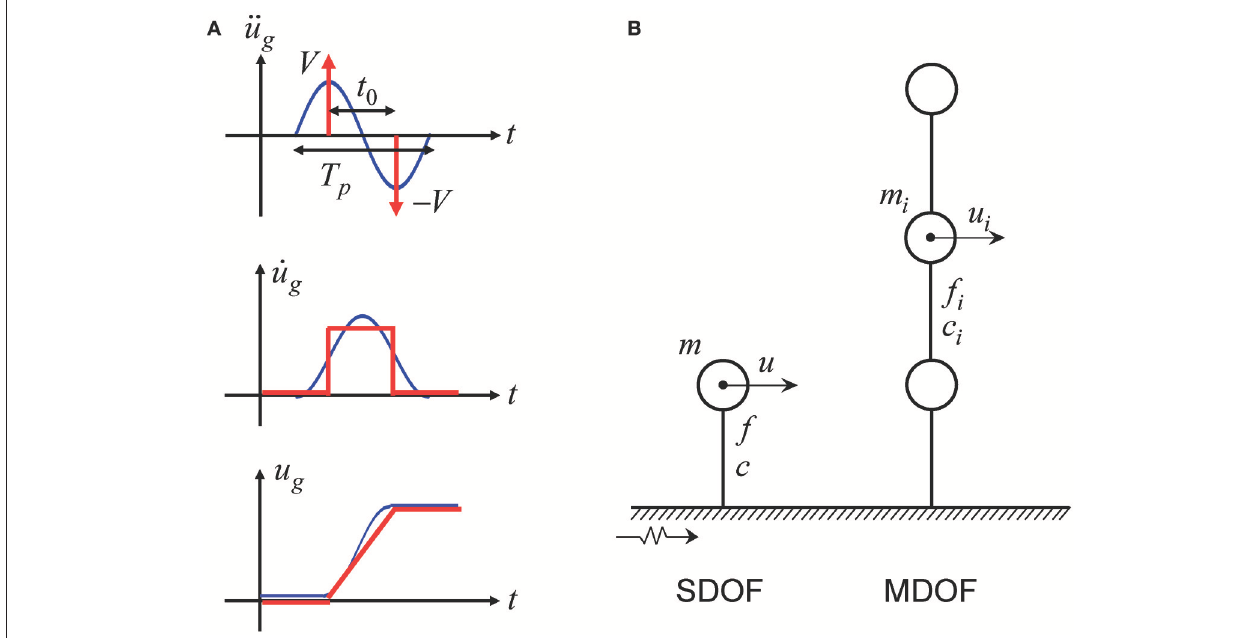
FIGURE 1 | Double impulse and structural models, (A) Acceleration, velocity, and displacement of the double impulse and the corresponding one-cycle sine wave, (B) SDOF model and MDOF model.